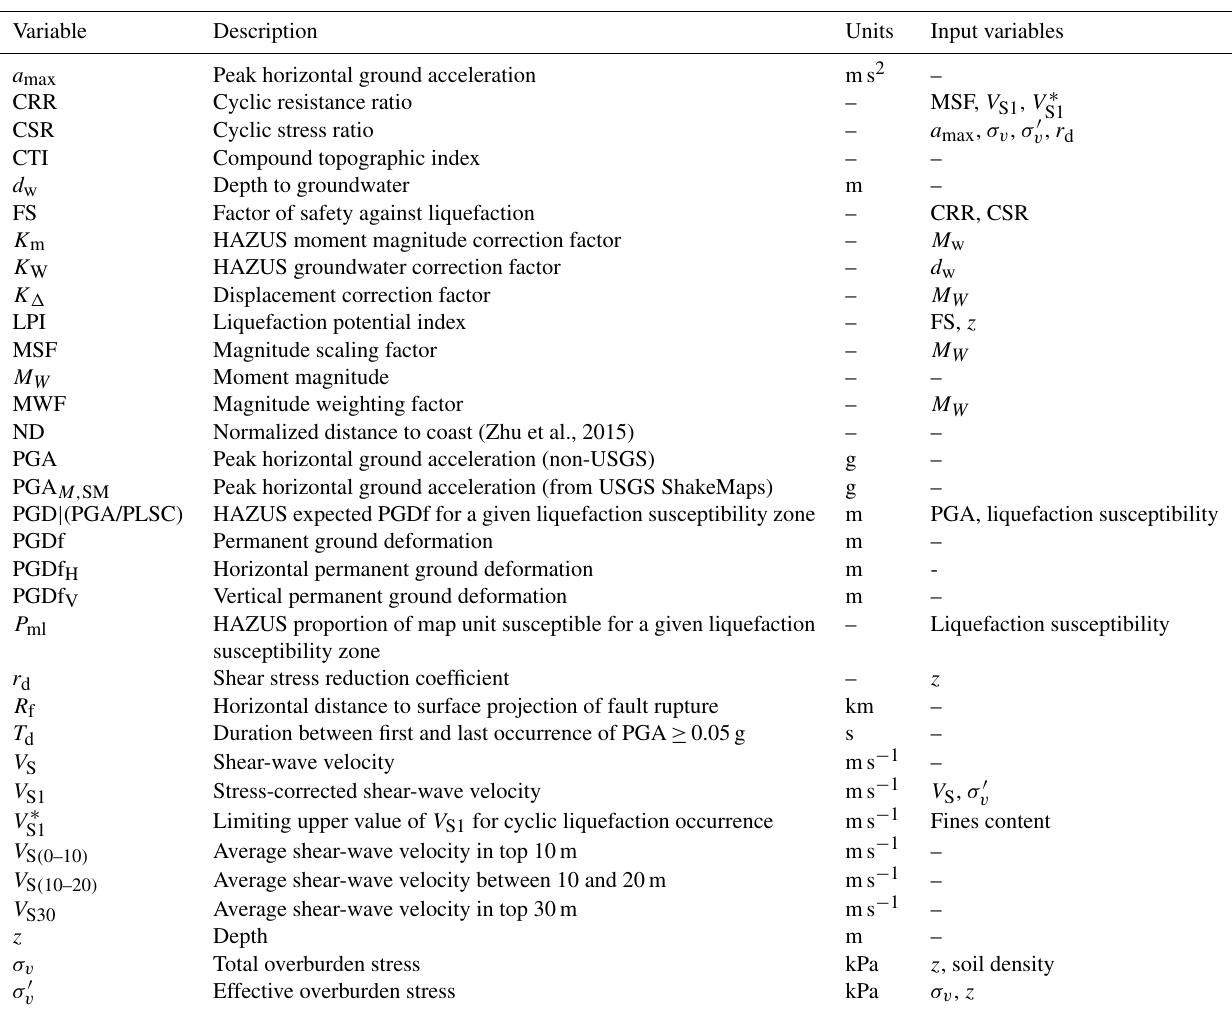
Table 2. Reference list of variables used in this paper.